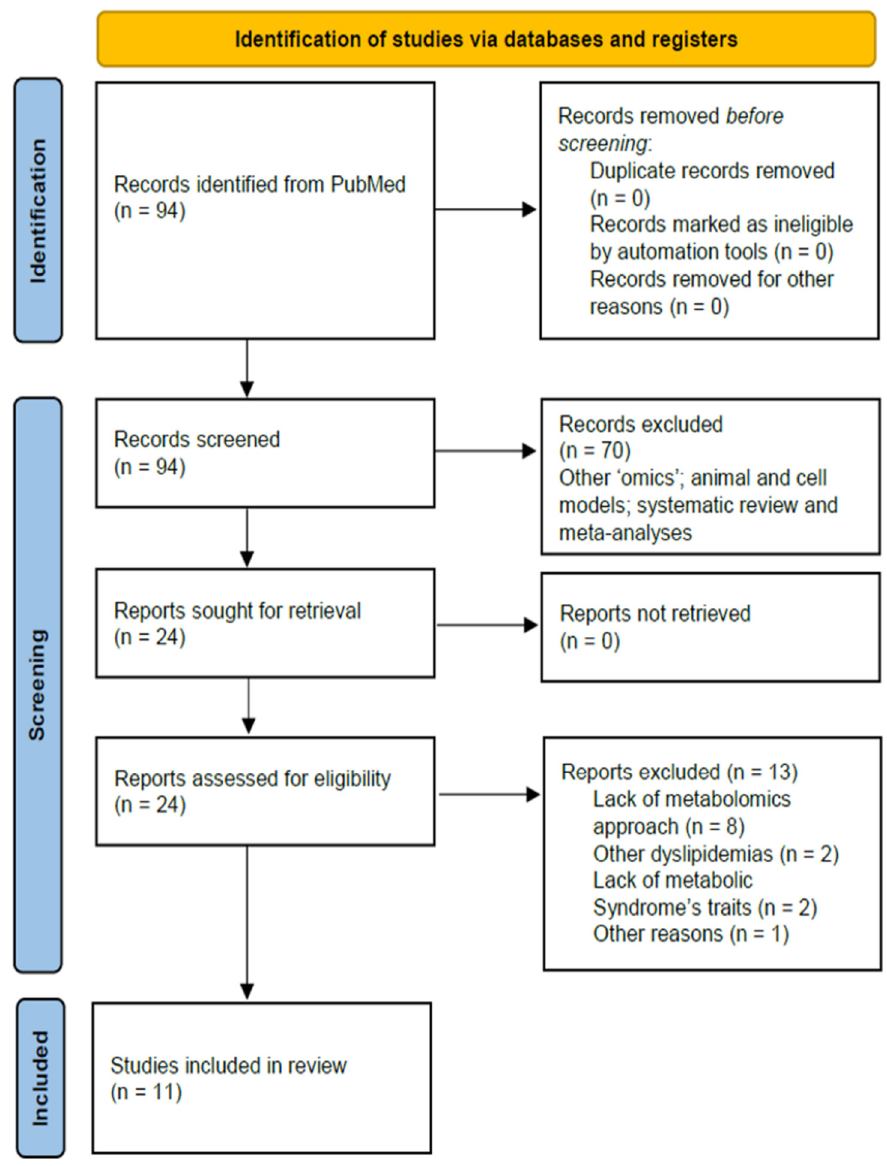
Figure 1. Flowchart of study selection. These articles were published between 2010 and 2021, the diagram shows the method by which relevant studies were retrieved from the databases, assessed, and selected, or excluded.